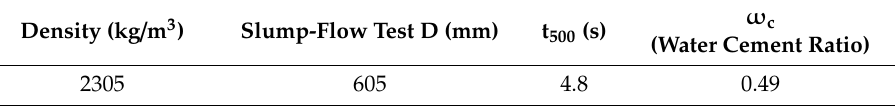
Table 3. The test results obtained on fresh concrete.